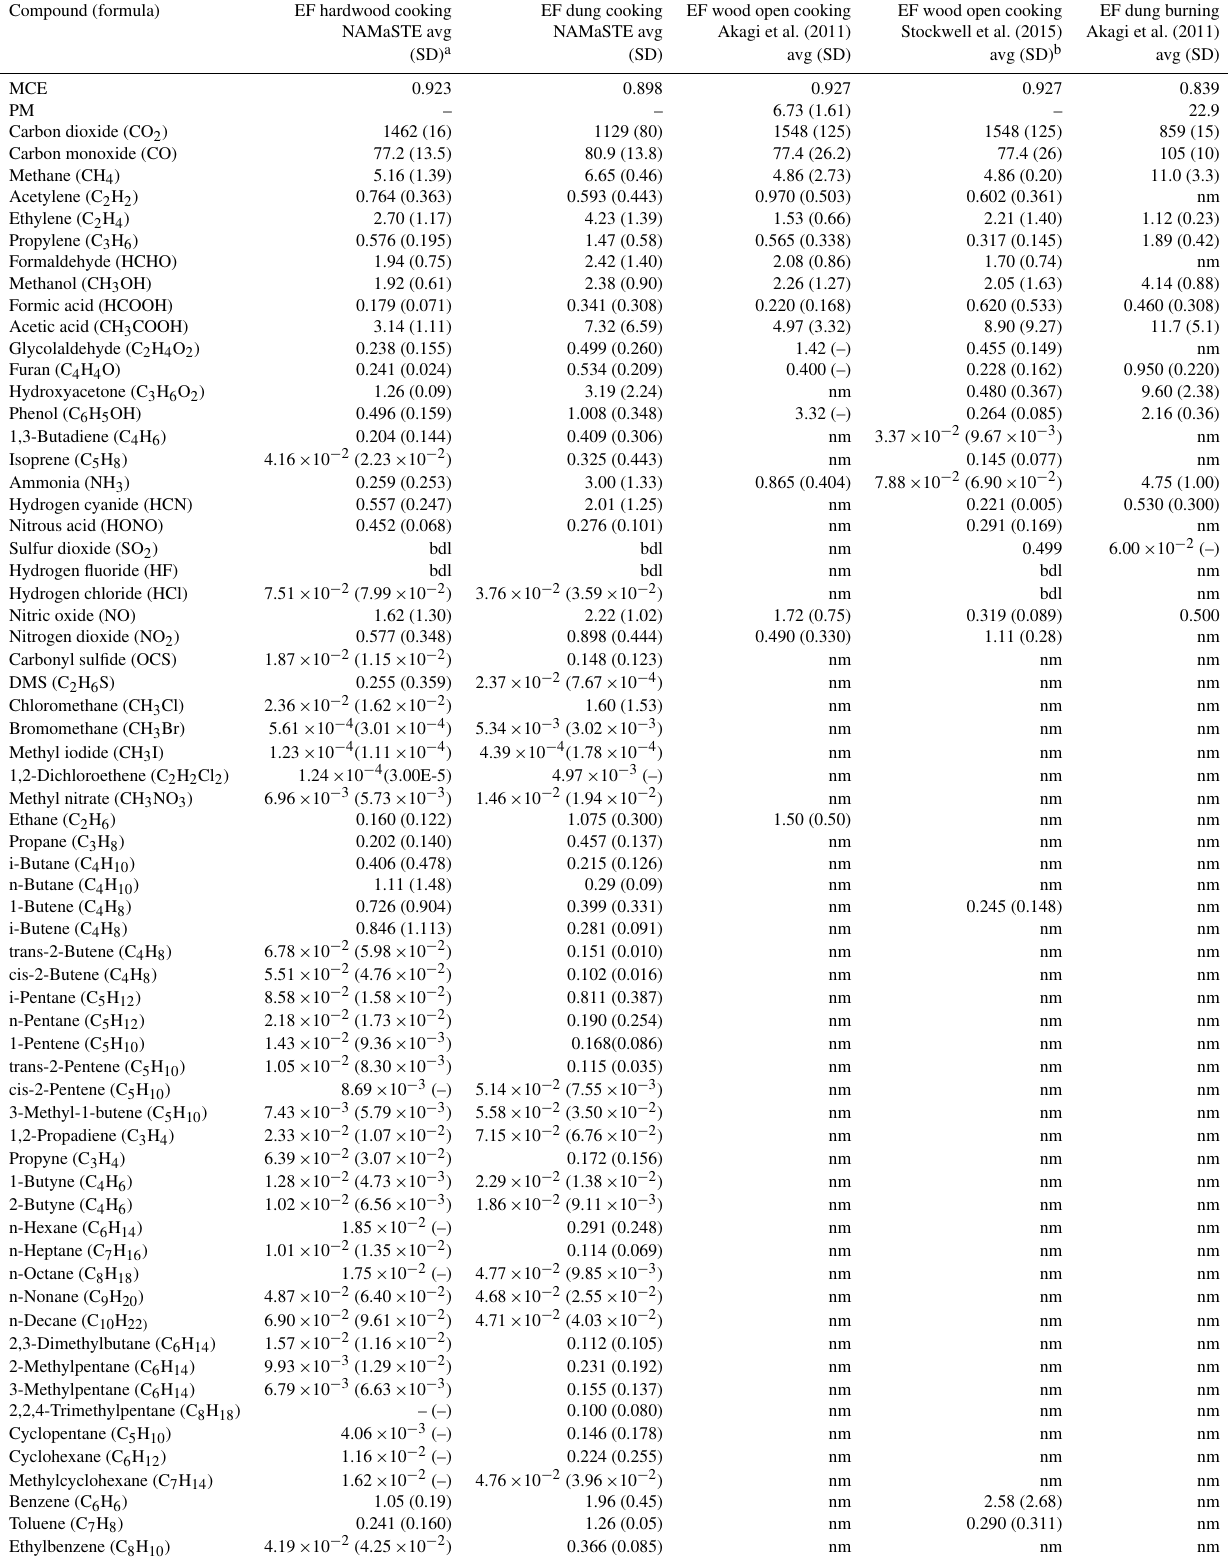
Table 4. Compiled emission factors (gkg − 1 ) and 1 standard deviation for open traditional cooking fires using dung and wood fuels. The NAMaSTE values include field measurements and adjusted laboratory